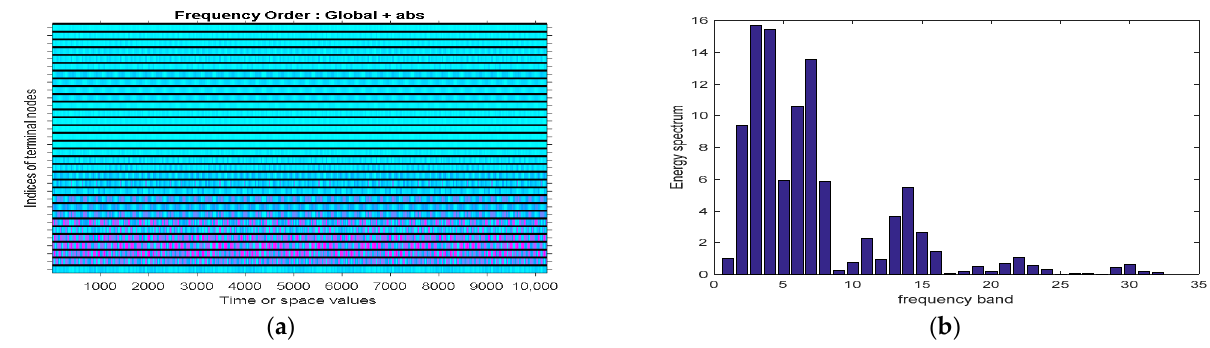
Figure 4. ( a ) Haar wavelet tree termination node; ( b ) energy spectrum of Haar wavelet decomposition.